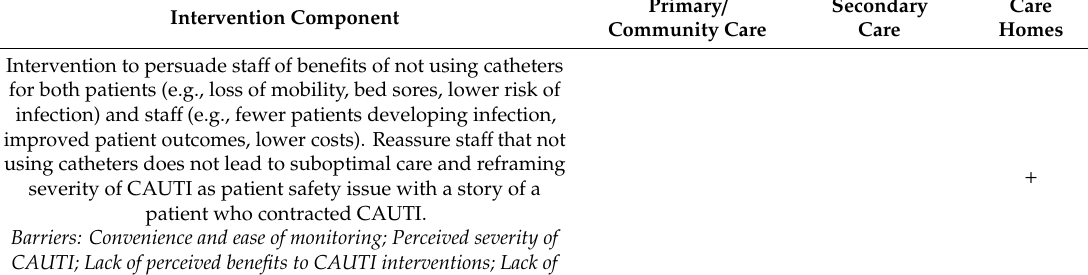
Intervention Component